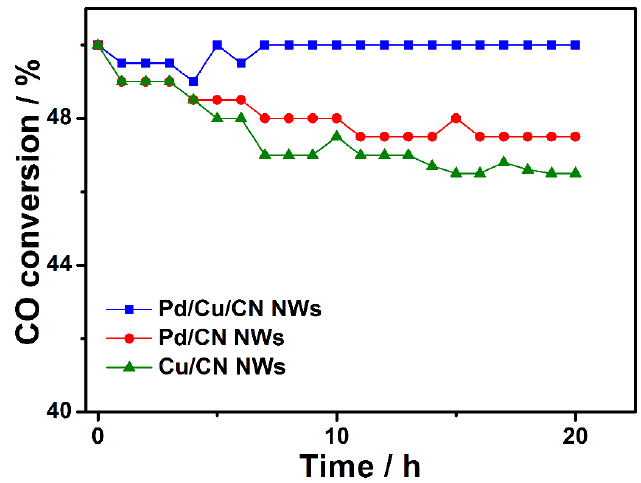
Figure 7. The stability tests the as-prepared catalysts measured for 20 h at T50.